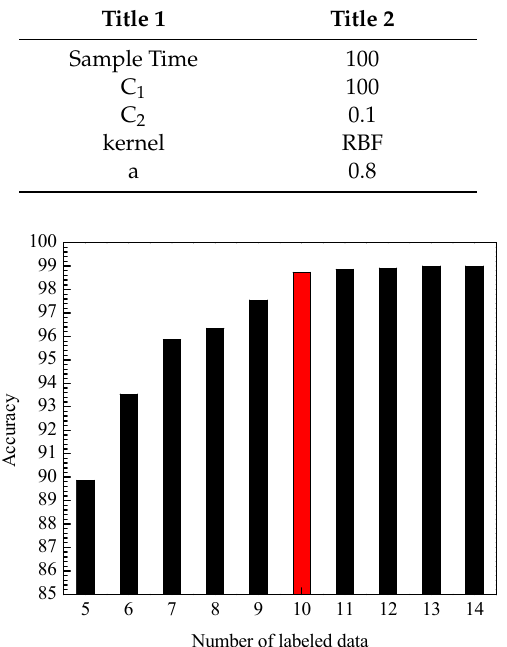
Table 5. Parameters of PCA-DAS4VM.